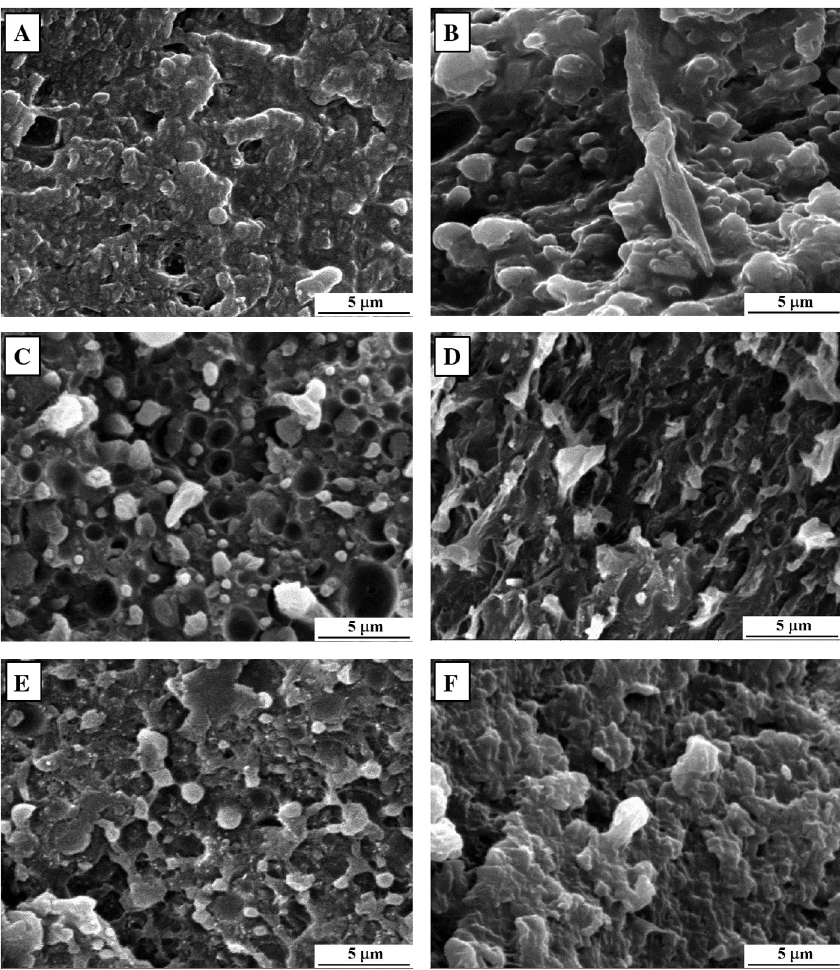
Figure 3 SEM micrographs of (A) PPO, (B) PPO2.5C, (C) PPO5.0C, (D) PPO7.5C, (E) PPO5.0S, (F)